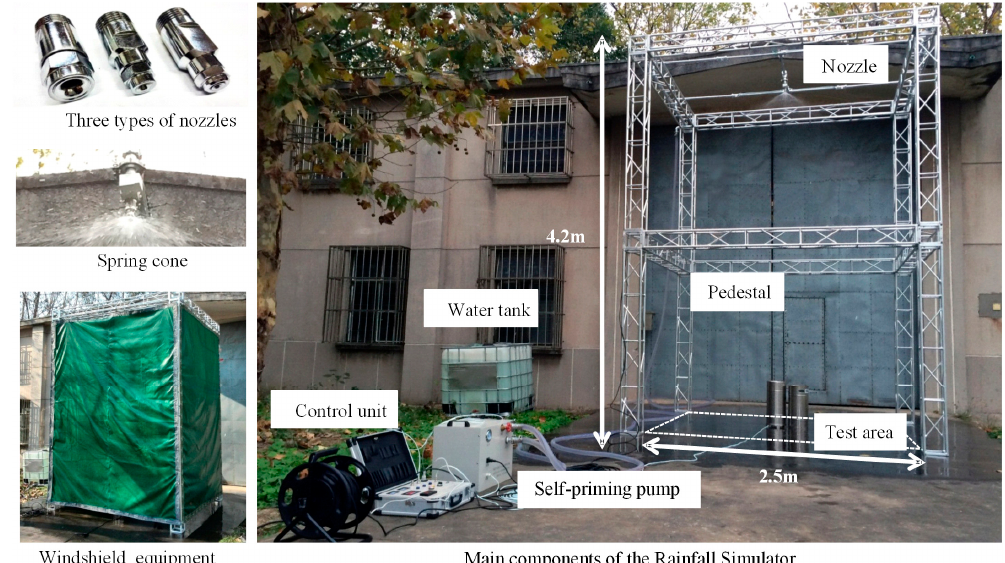
Figure 1. The rainfall simulator and its primary components.